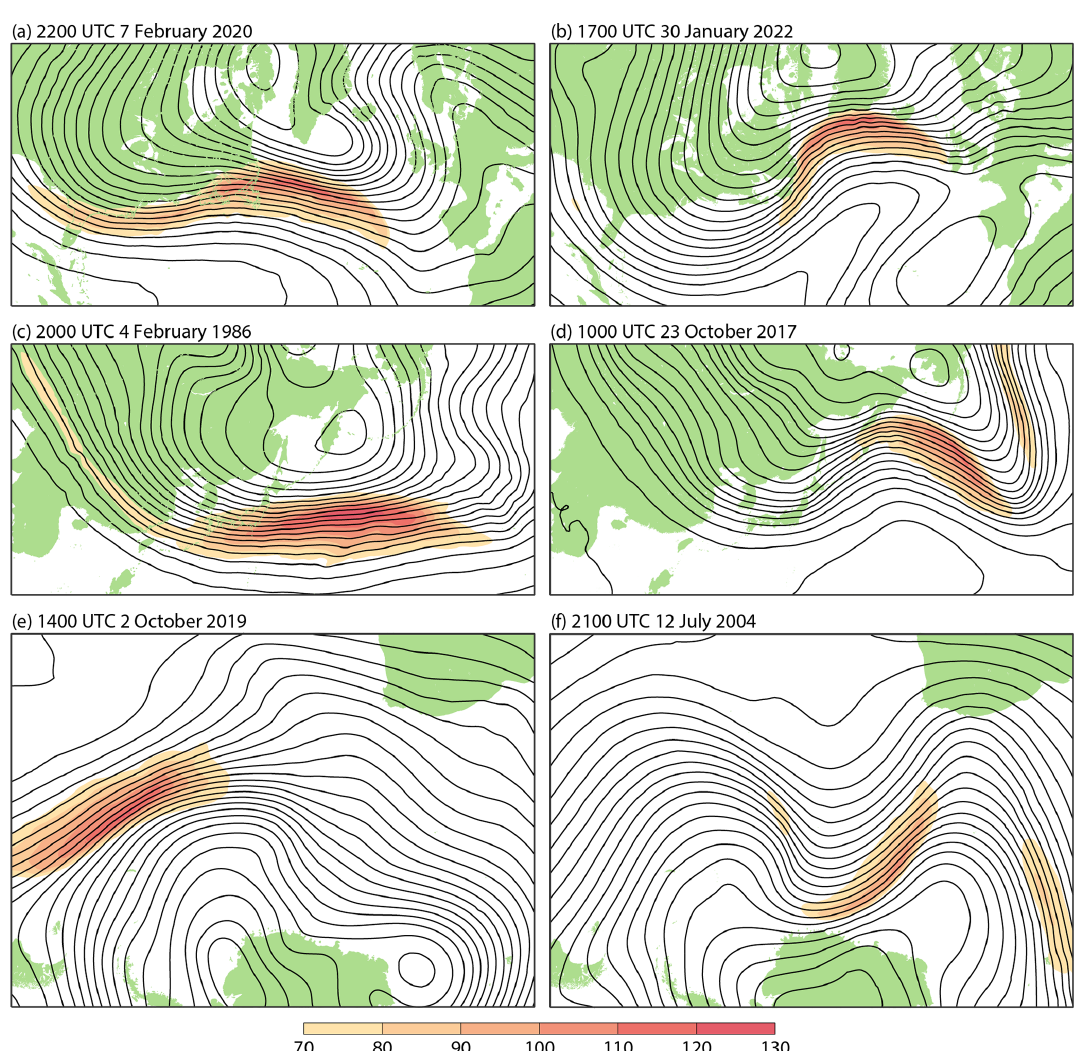
Figure 17. The 200hPa geopotential height (contour interval 8dam) and wind speed (shading interval 10ms − 1 for speeds ≥ 70ms − 1 ), showing North Atlantic jet streams for (a) 22:00UTC on 7 February 2020 and (b) 17:00UTC on 30 January 2022, North Pacific jet streams for (c) 20:00UTC on 4 February 1986 and (d) 10:00UTC on 23 October 2017, and South Atlantic jet streams for (e) 14:00UTC on 2 October 2019 and (f) 21:00UTC on 12 July